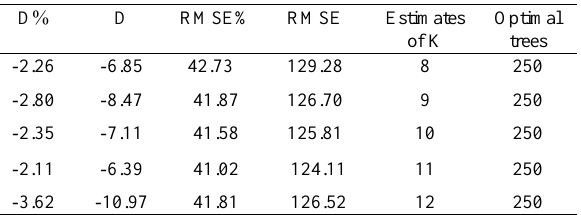
Table 2 represents the evaluation criteria resulted from the random forest with different number of k in estimating